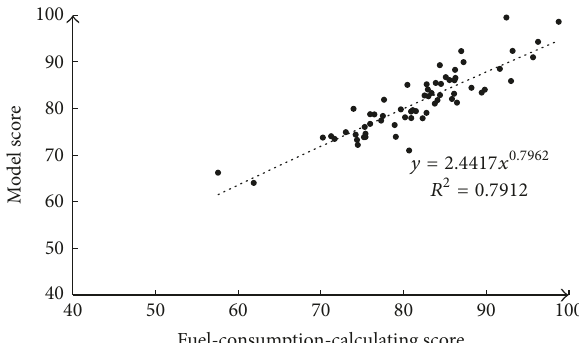
Figure 6: Relationship between fuel consumption-calculating score and model